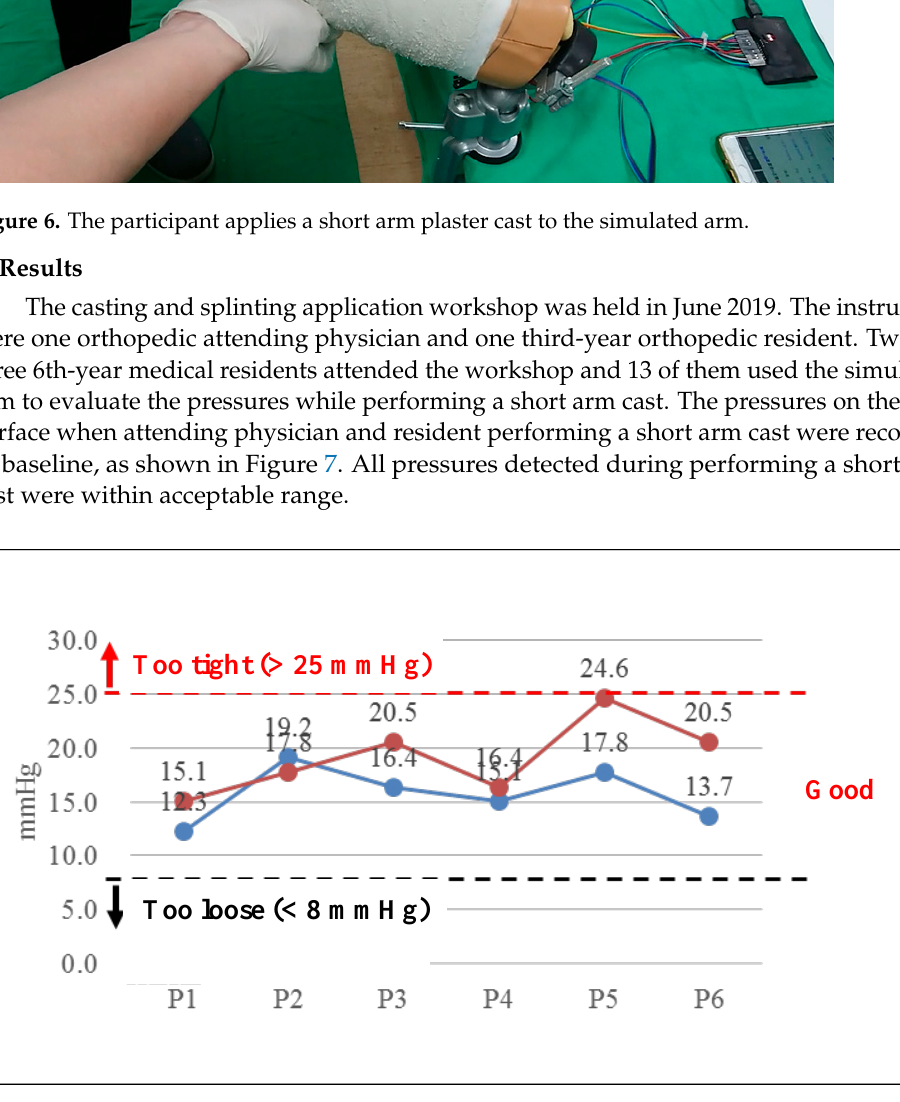
Figure 7. The pressures of P1-P6 when attending physicians and resident applying a short arm cast.